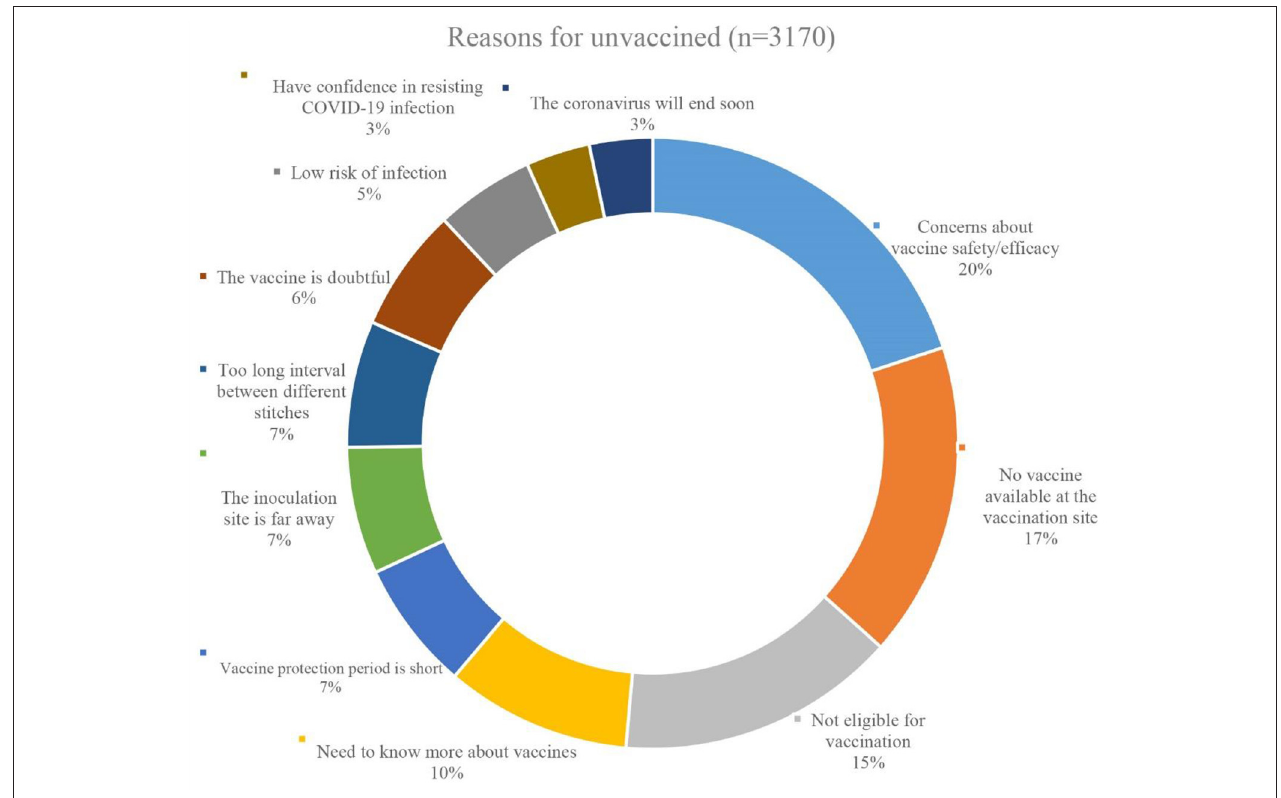
FIGURE 3 | The reasons for unvaccinated ( n =